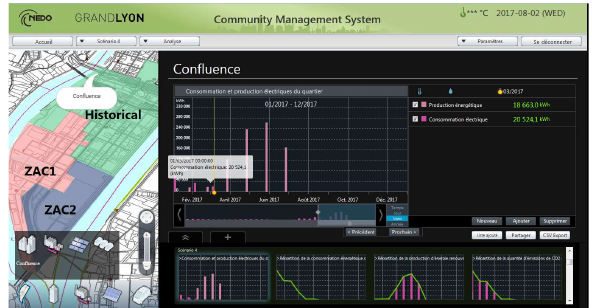
Figure 16. Version 1 of the Community Management System: Energy Visualisation and analysis tool at the Confluence of the